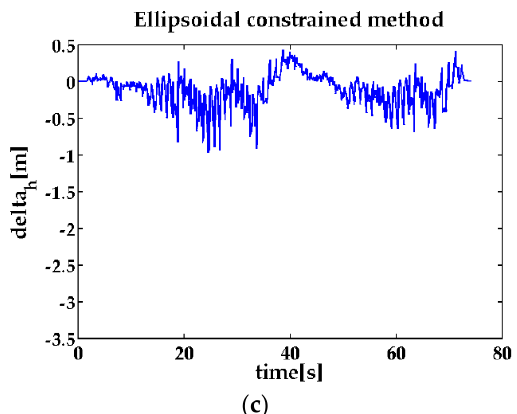
Figure 5. Left and right feet altitude difference in 2D the closed path experiment. ( a ) the height difference of the two feet without contraint; ( b ) the height difference of the two feet with spherical constraint; ( c ) the height difference of the two feet with ellipsoidal constraint.